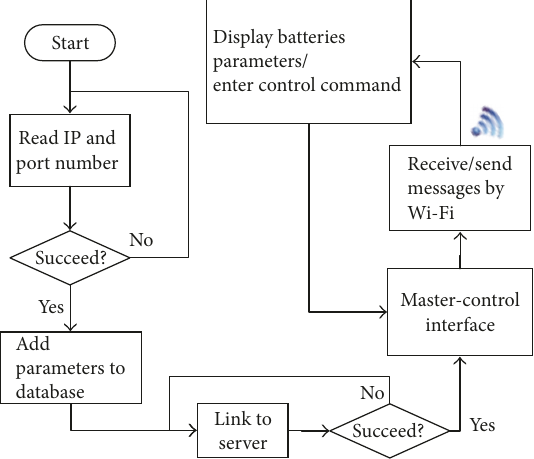
Figure 2: Architecture of the BMS (upper